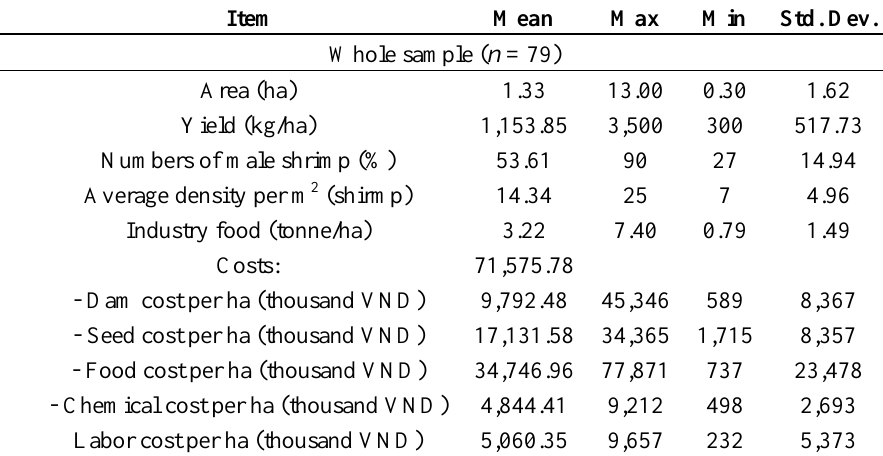
Table A2. Summary of statistical variables in the aquaculture